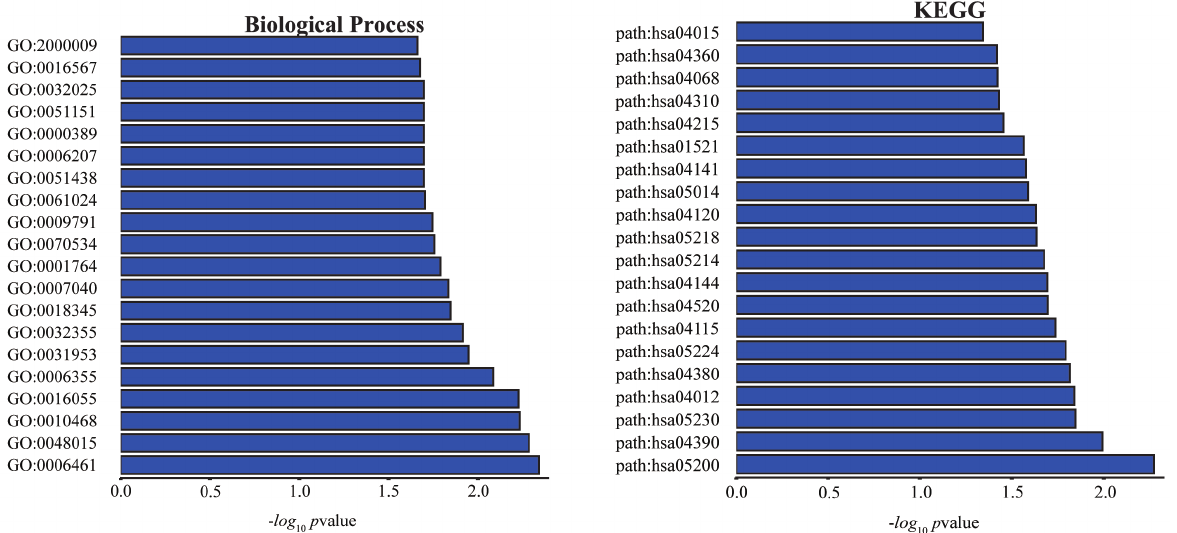
Figure 3. Biological Process GO terms (a) and KEGG pathways (b) enriched in the target genes of miR-1273g-3p.